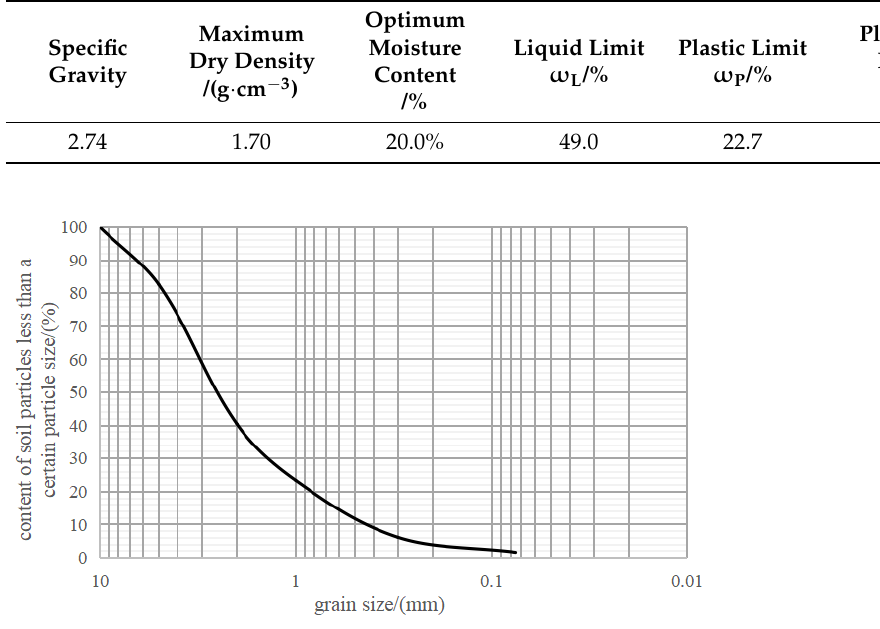
Figure 1. Particle gradation curve of red clay.